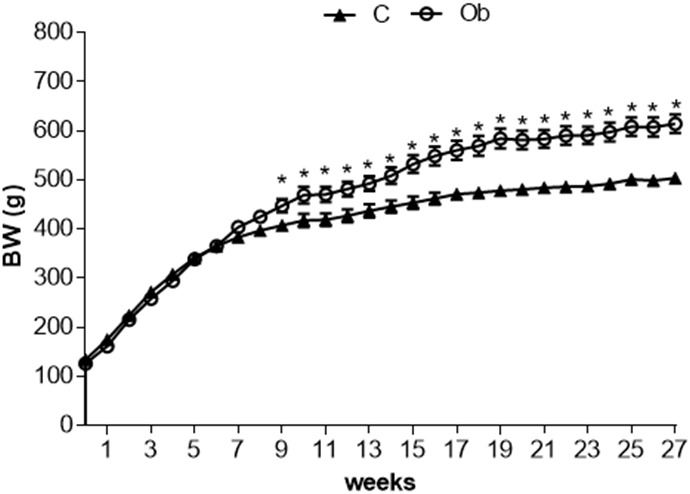
Evolution of body weight at 27 week of experimental protocol of obesity. C, control; Ob, obese; BW, body weight. Data are reported as the means ± SEM. Two-way ANOVA repeated measures for independent samples followed by Tukey post hoc test. ∗p < 0.05 Ob vs. C.